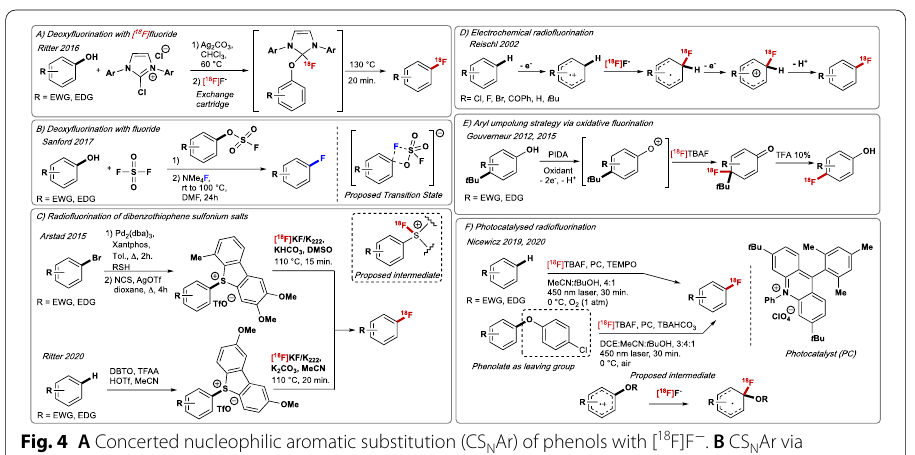
Fig. 4 A Concerted nucleophilic aromatic substitution (CS N Ar) of phenols with [ 18 F]F − . B CS N Ar via aryl fluorosulfonate intermediates. C Dibenzothiophene sulfoniums as leaving groups for aromatic 18 F-fluorination. D Electrochemical radiofluorination. E Aryl umpolung strategy with the use of external oxidant. F Photoredox radiofluorination. EWG electron-withdrawing group. EDG electron-donating = = group. NCS N -Chlorosuccinimide. DBTO dibenzothiophene S -oxide. TFAA trifluoroacetic anhydride. = = = TfOH triflic acid. PIDA phenyliodine diacetate. PC = = =